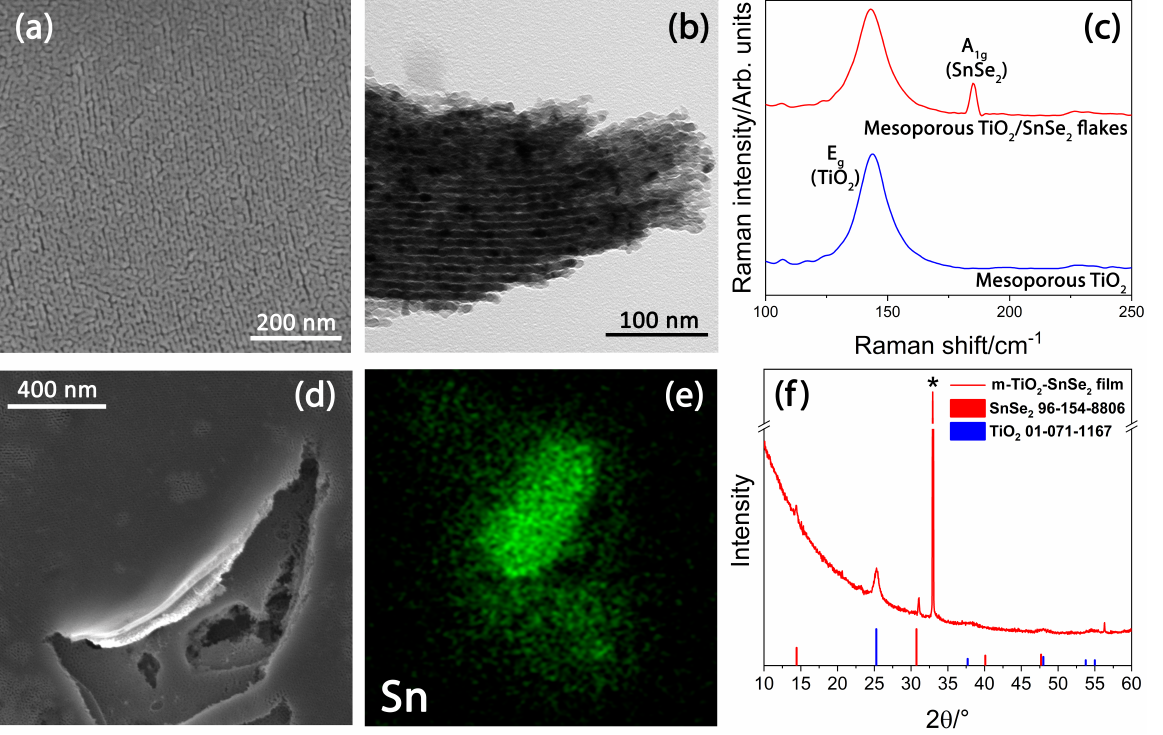
Figure 5. ( a ) FESEM and ( b ) TEM images of m-TiO 2 -SnSe 2 film. ( c ) Raman comparison of m-TiO 2 film (blue line) and m-TiO 2 -SnSe 2 film (red line). ( d , e ) FESEM image and EDS analysis of SnSe 2 flakes into m-TiO 2 film and ( f ) GI-XRD pattern of m-TiO 2 -SnSe 2 film. The asterisk indicates the (200) diffraction of the Si